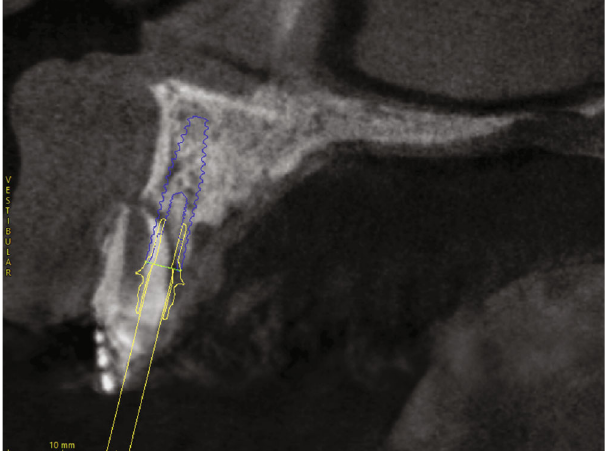
Figure 3: Virtual implant placement in the optimal position for future prosthetic